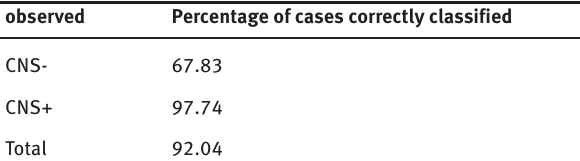
Table 8: Cross-validation